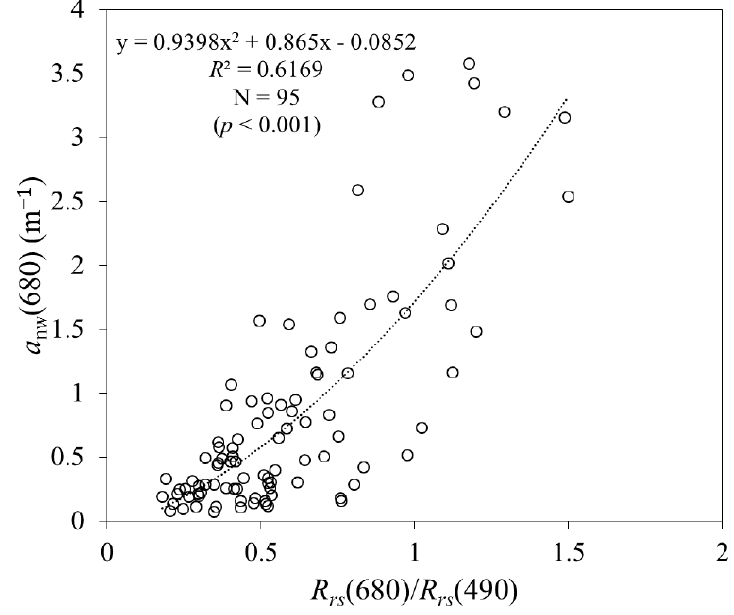
Figure 3. Scatter plot of in situ measured a nw (680) values versus R rs (680)/ R rs (490) spectral ratios. Remote Sens. 2017 , 9 , 1192